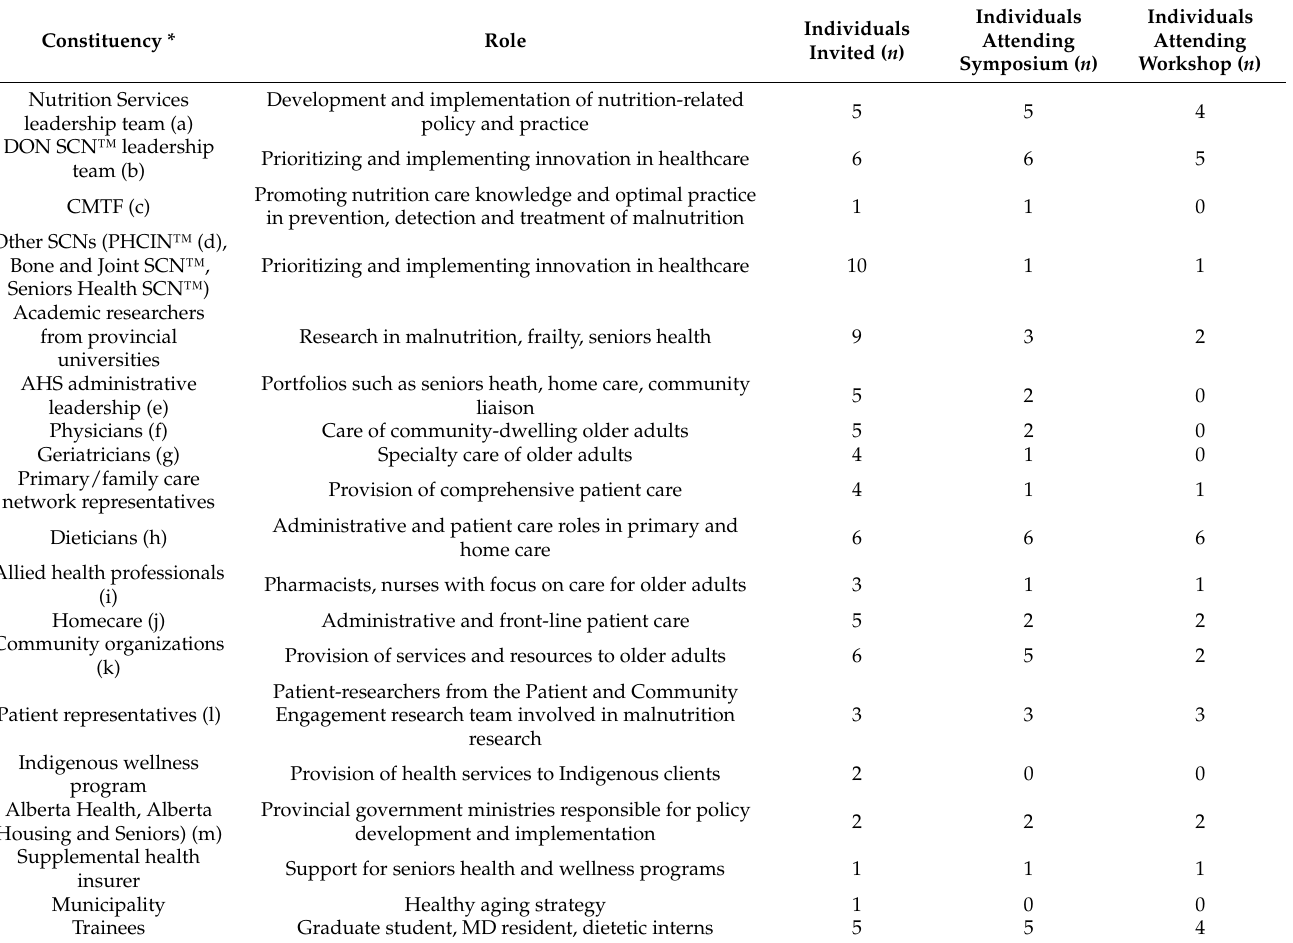
Table 1. Constituencies invited and represented at the Symposium and